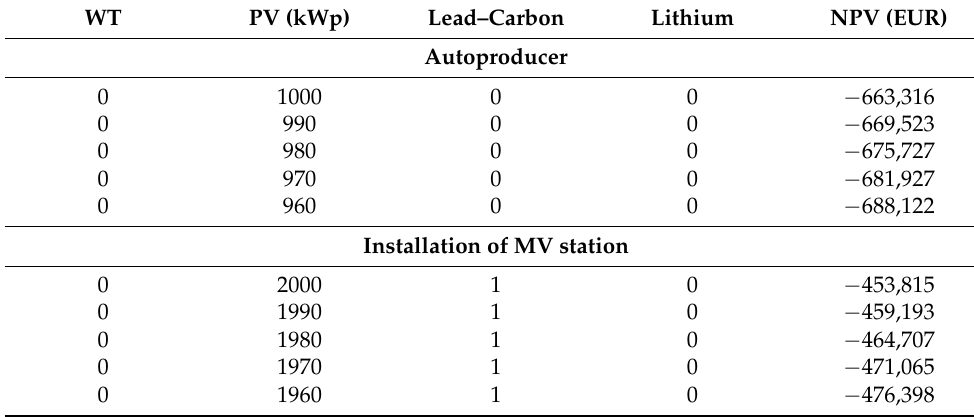
Table 11. Optimal results for Imperial College London.